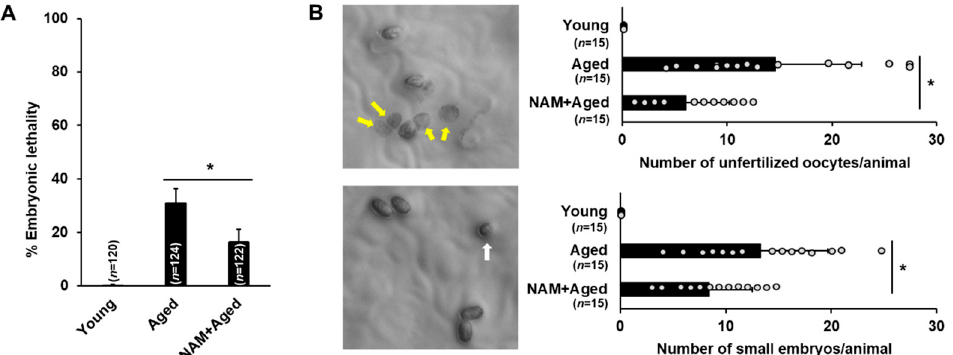
Figure 1. The fertility of aged oocytes is improved by nicotinamide (NAM) supplementation in Caenorhabditis elegans : ( A ) The percentage of embryonic lethality among the total number of progenies produced by young, aged, and NAM-treated aged (NAM+aged) N2 hermaphrodites. Error bars represent standard deviation (SD). *, p < 0.05 (one-way ANOVA with Tukey’s post hoc test); ( B ) The number of unfertilized oocytes (upper graph) and small embryos (bottom graph) among the total number of progenies of young, aged, and NAM+aged N2 hermaphrodites. Representative images of unfertilized oocytes (indicated by yellow arrows) and a small embryo (indicated by a white arrow). Error bars represent SD. *, p < 0.05 (one-way ANOVA with Tukey’s post hoc test).